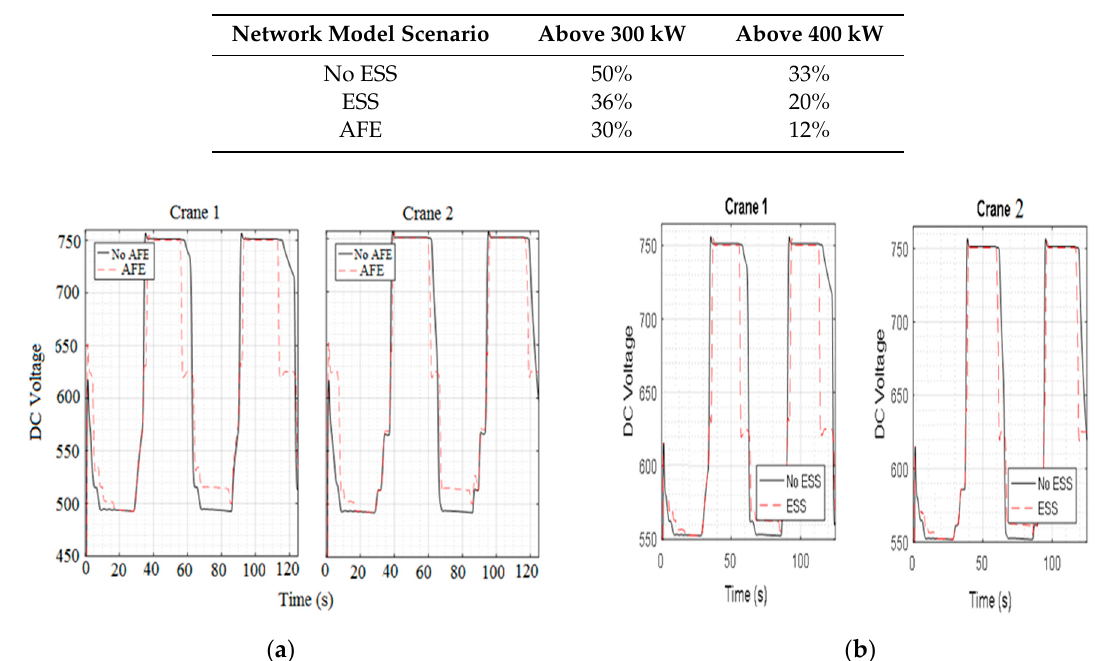
Figure 10. An example for the DC voltage curve of network of crane (( a ) AFE model ( b ) ESS model).